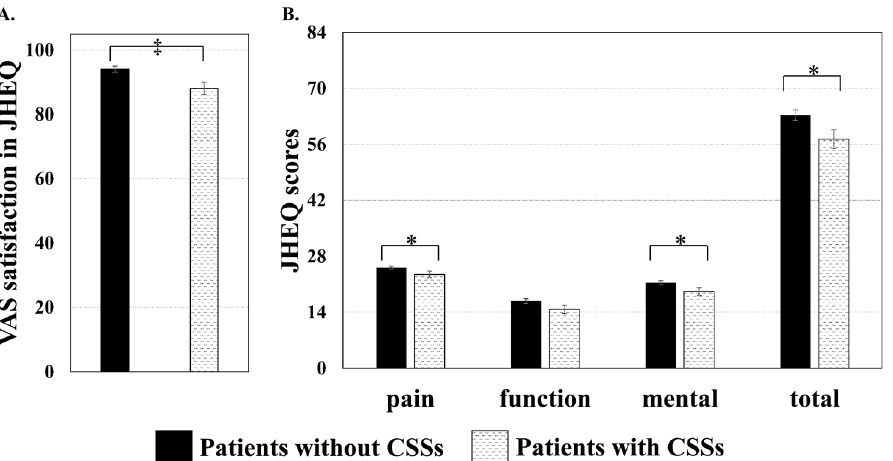
Figure 3. JHEQ scores at 6 months after total hip arthroplasty in patients with and without CSSs. ( A ) VAS satisfaction on JHEQ. ( B ) Pain, function, mental, and total scores on JHEQ. *P < 0.05 and ‡ P < 0.001. VAS visual analog scale, CSS central sensitivity syndrome, JHEQ Japanese Orthopedic Association Hip-Disease Evaluation Questionnaire.